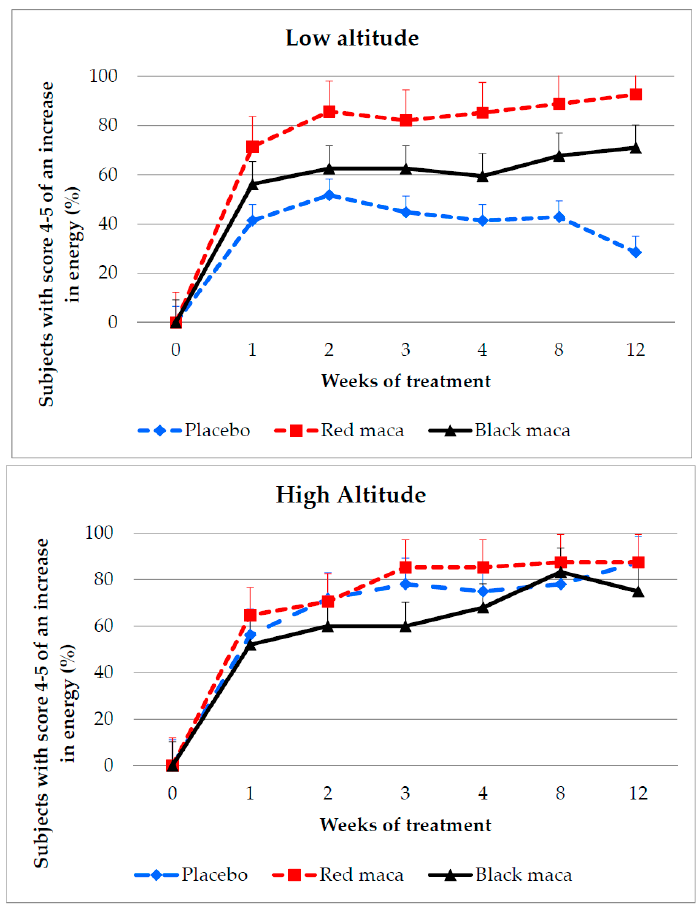
Figure 3. Percentage of subjects perceiving an increase in energy after treatment for 12 weeks with a placebo, red maca, or black maca at low ( Upper ) and high ( Bottom ) altitude. LA: p = 0.07; 0.02; 0.01; 0.003; 0.001 and <0.00001 using chi square test at weeks 1, 2, 3, 4, 8, and 12 comparing treatment with placebo, red maca, or black maca. Placebo group: p > 0.05 over time (weeks 1 to 12); red maca group: p = 0.0001 over time (weeks 1 to 12); black maca group: p > 0.05 over time (weeks 1 to 12). HA: p > 0.05 between placebo group and groups with red or black maca (chi square test at weeks 1, 2, 3, 4, 8 and 12). Placebo: p = 0.0001; red maca: p = 0.0001; black maca: p = 0.0001 over time (weeks 1 to 12).